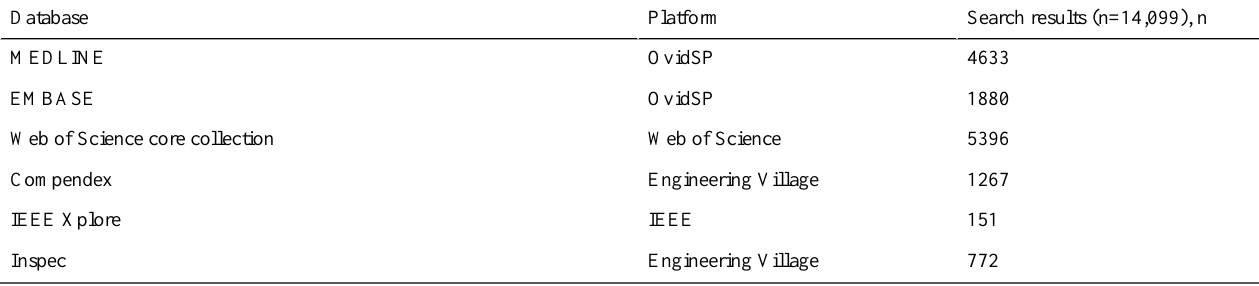
Table 1. Databases and search results.